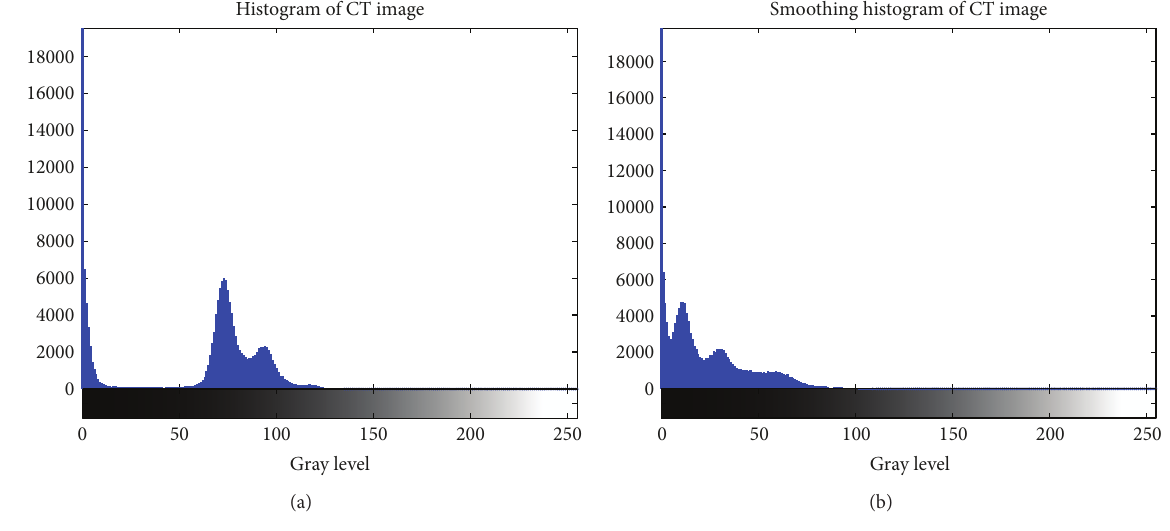
Figure 7: Histogram and smoothing histogram of CT slice.